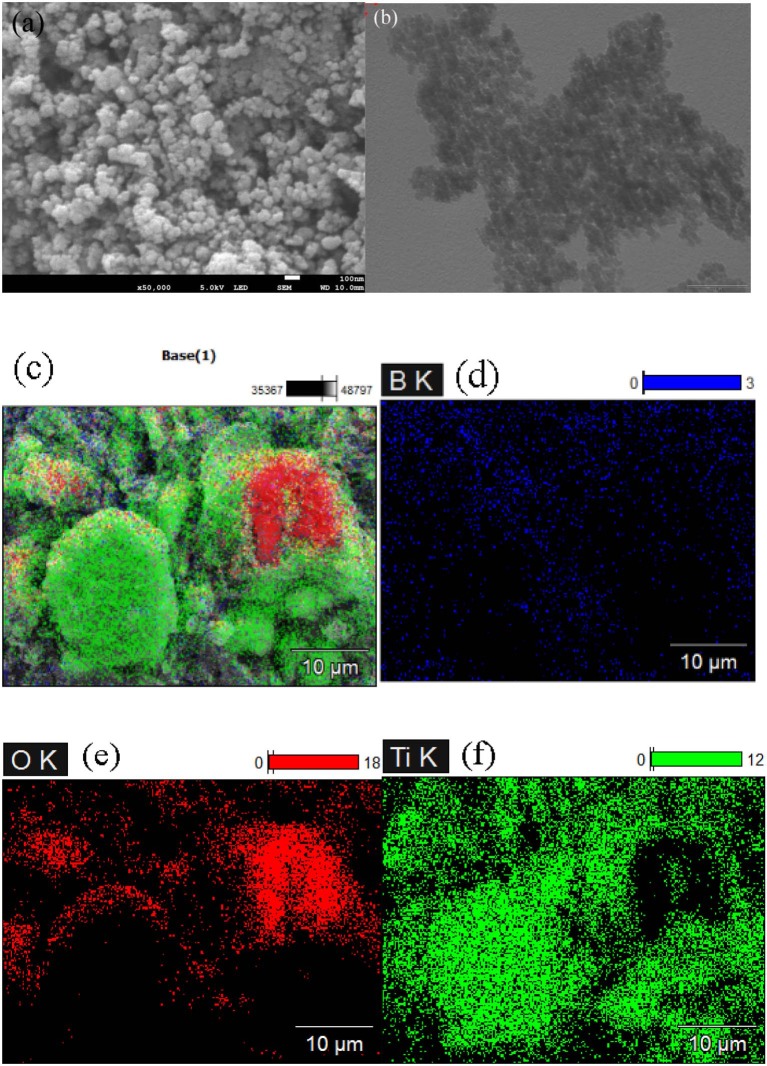
(a) SEM and (b) TEM imagines of 6B-TiO2; (c–f) the elemental mapping of 6B-TiO2.